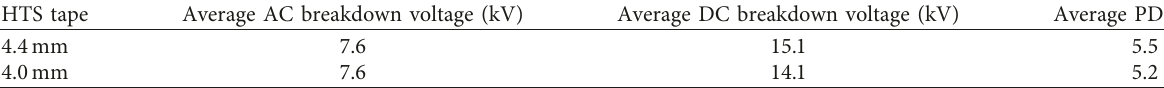
Table 2: Electrical properties of small scale samples in LN